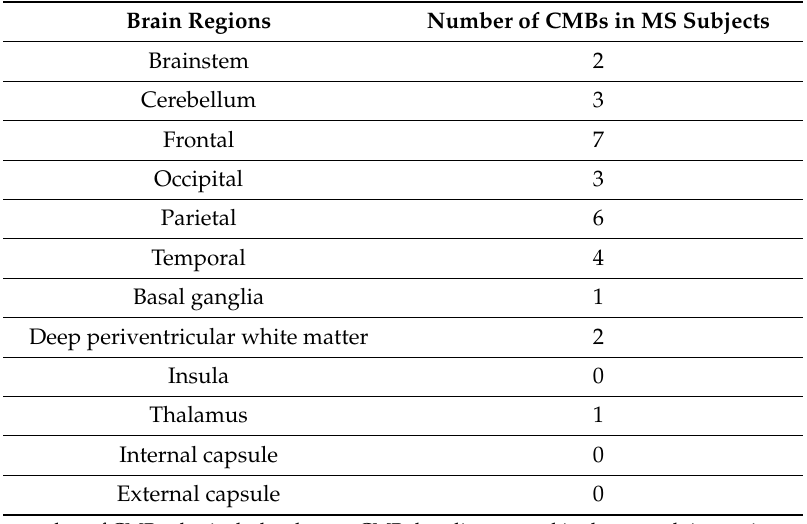
Table 3. CMB distribution in brain regions according to the Microbleed Anatomic Rating Scale (MARS) confirmed by both raters on 112 subjects (cohort 2). A total of 29 microbleeds (from both time point scans) have had their locations categorized in this